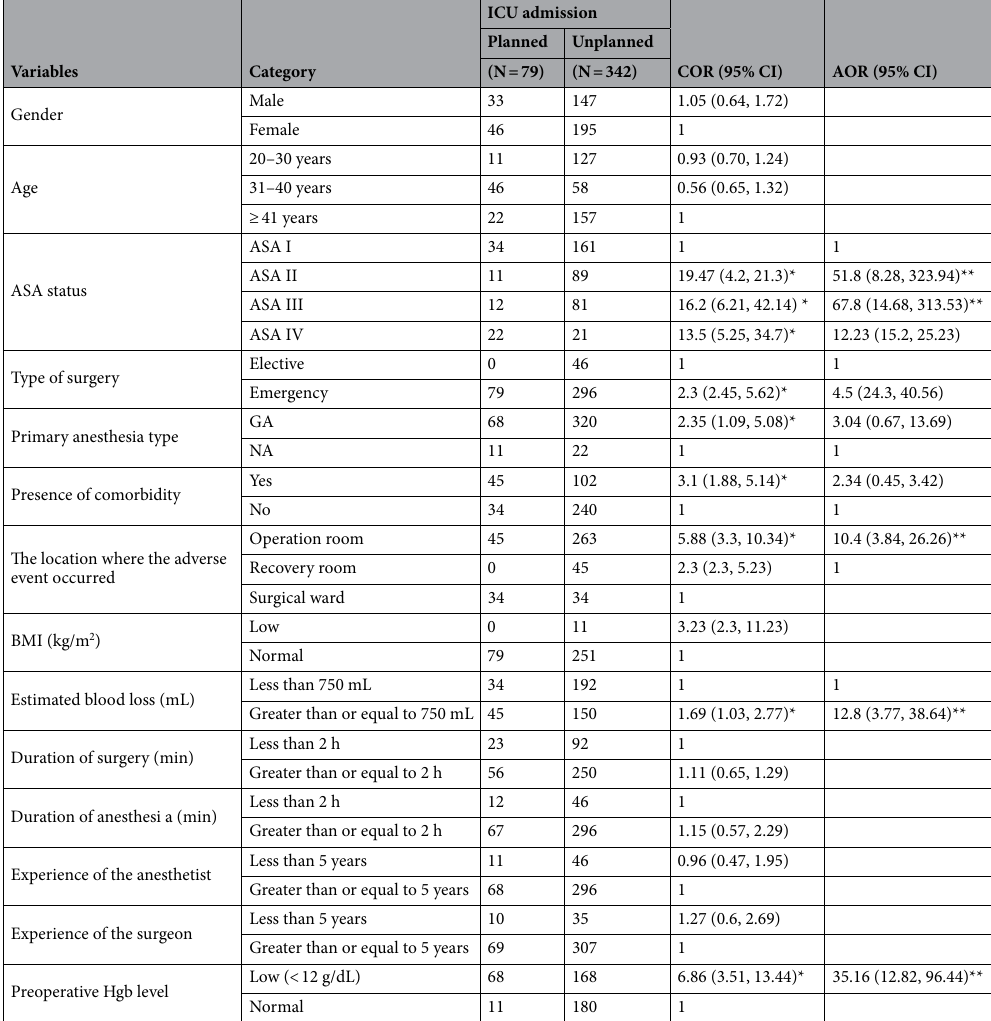
Table 3. Factors associated with intensive care unit admission following surgery, 2021. ASA American Society of Anesthesiologists, GA general anesthesia, NA neuraxial anesthesia, BMI Body mass index, COR crude odds ratio, AOR adjusted odds ratio, CI confidence interval, *(p-value < 0.2) Crude odds ratio, **(P value < 0.05) adjusted odds ratio, N number, Hgb hemoglobin, g/dL grams per